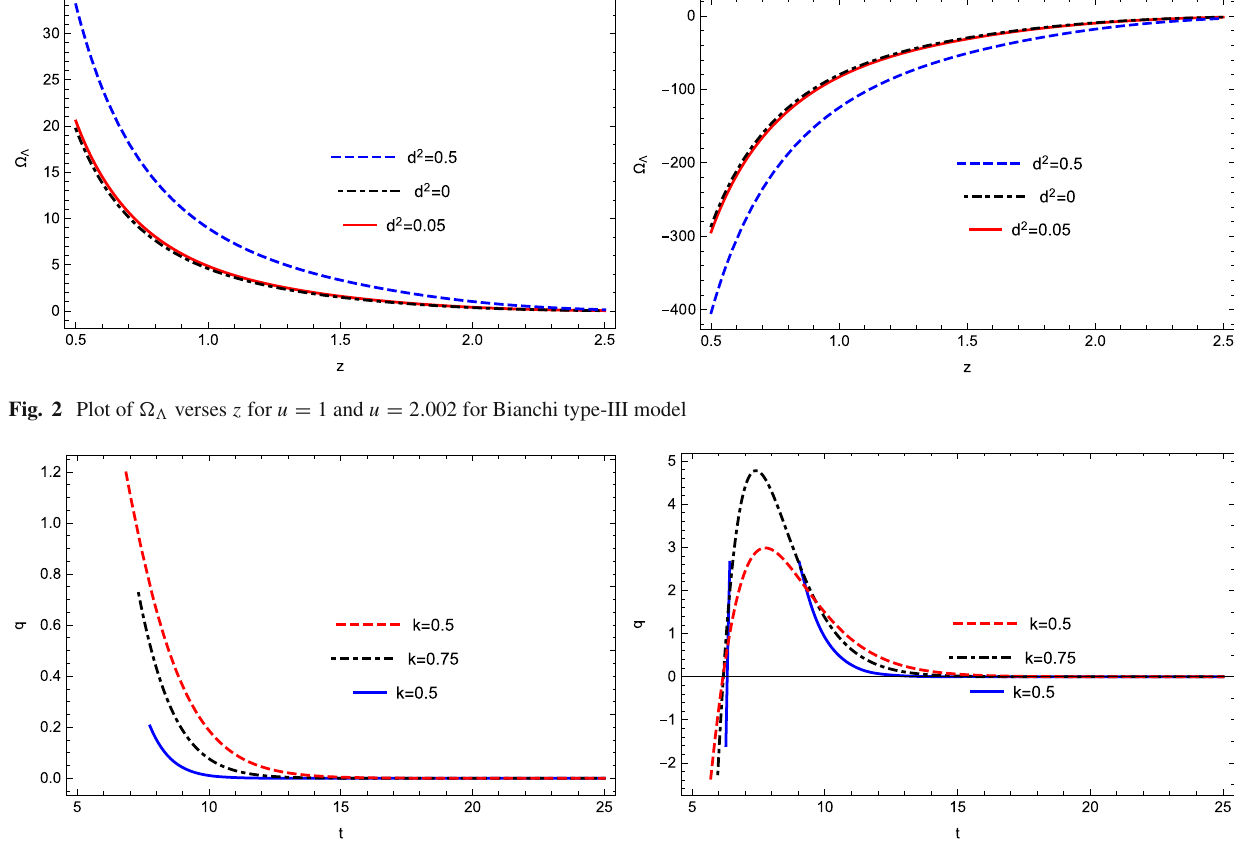
Fig. 3 Plot of q verses t for n = − 2 . 8 and n = − 3 . 8 for Bianchi type-III model